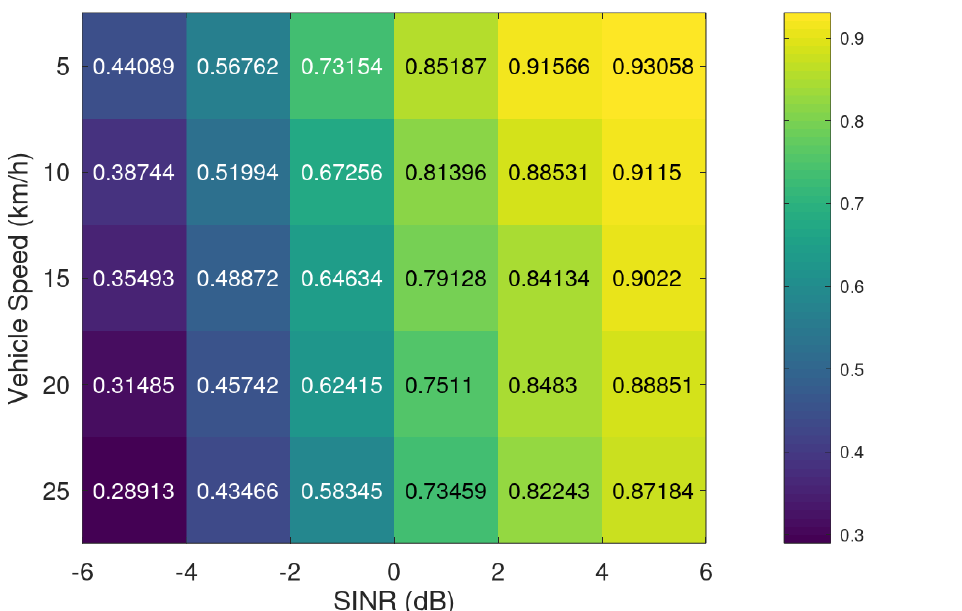
Figure 10. Performance colormap over vehicle speed and SINR in an equal-gain two-paths Rayleigh fading channel with delay 2 us.